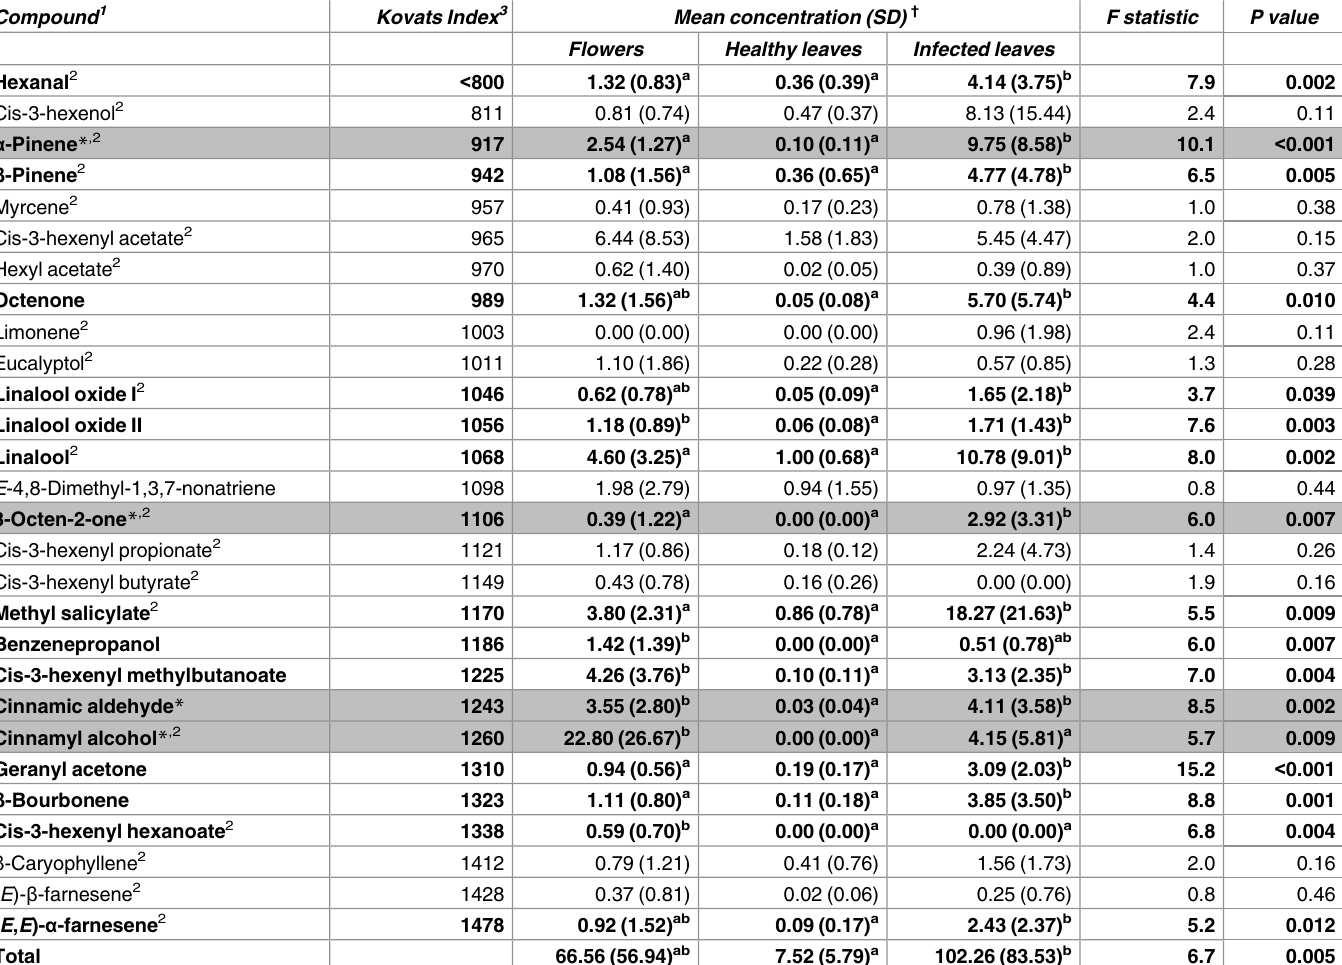
Table 1. Concentrations of volatile compounds quantified from Vaccinium corymbosum flowers, healthy leaves, and leaves infected with Monili- nia vaccinii-corymbosi ( Mvc